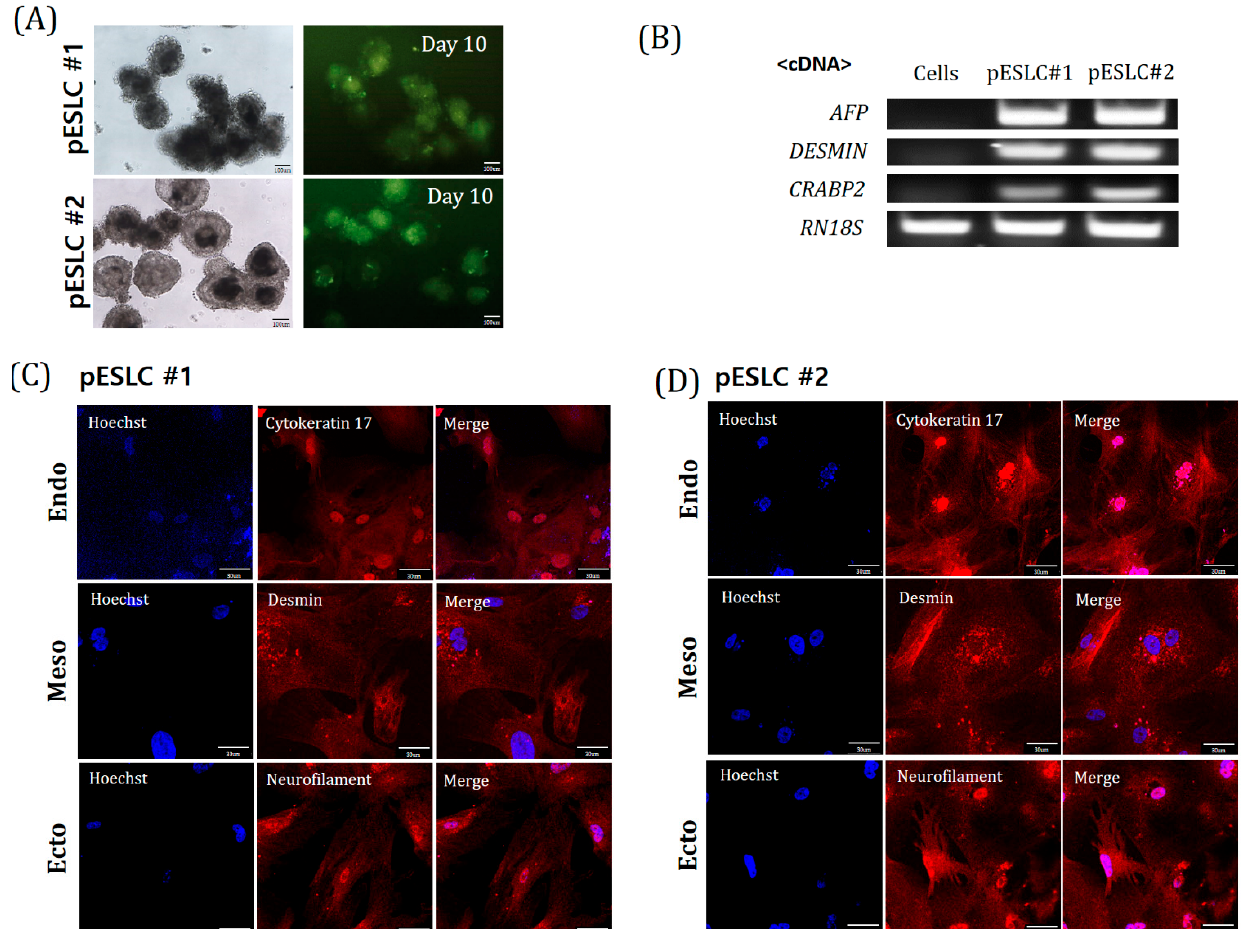
Figure 4. Differentiation potential analysis in Yucatan EGFP pESLC lines. ( A ) Morphology and EGFP expression of embryoid bodies (EBs) derived from pESLC lines. Scale bars = 100 mm. ( B ) The expression of marker genes Alpha-fetoprotein (AFP ; endoderm), Desmin (mesoderm), and Cellular retinoic acid binding protein 2 (CRABP2 ; ectoderm) involved in differentiation in the EBs. RN18s was used as a control. ( C , D ) The expression of the differentiation marker Cytokeratin 17 (endoderm), Desmin (mesoderm), and Neurofilament (ectoderm) from EBs by IF analysis. Scale bars = 30 mm.